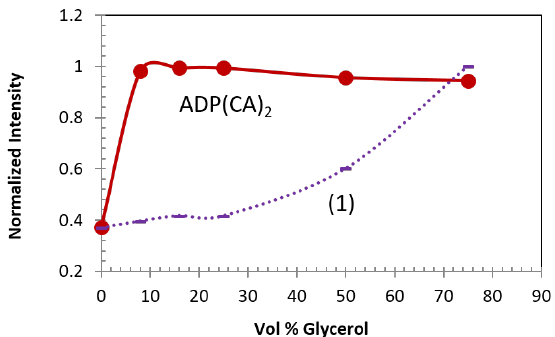
Figure 3. Viscosity-dependent fluorescence intensity of ADP(CA) 2 in a glycerol/ethylene glycol mixture with different compositions. Excitation: 655 nm; Emission filter: 711/25 band-pass; Laser energy: 50 pJ (ADP(CA) 2 ) and 140 pJ (Compound ( 1 )).